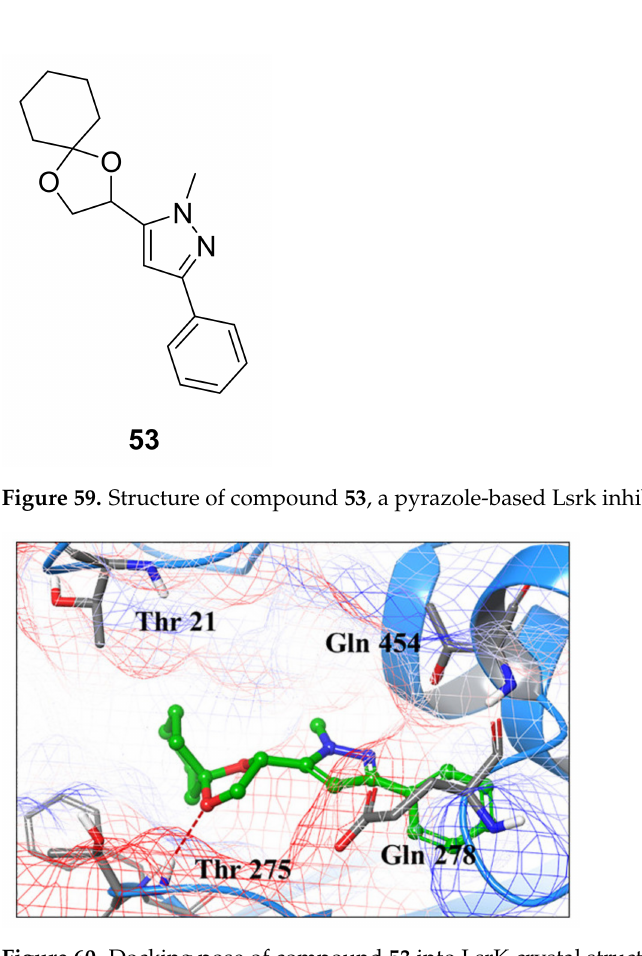
Figure 60. Docking pose of compound 53 into LsrK crystal structure [64,65].